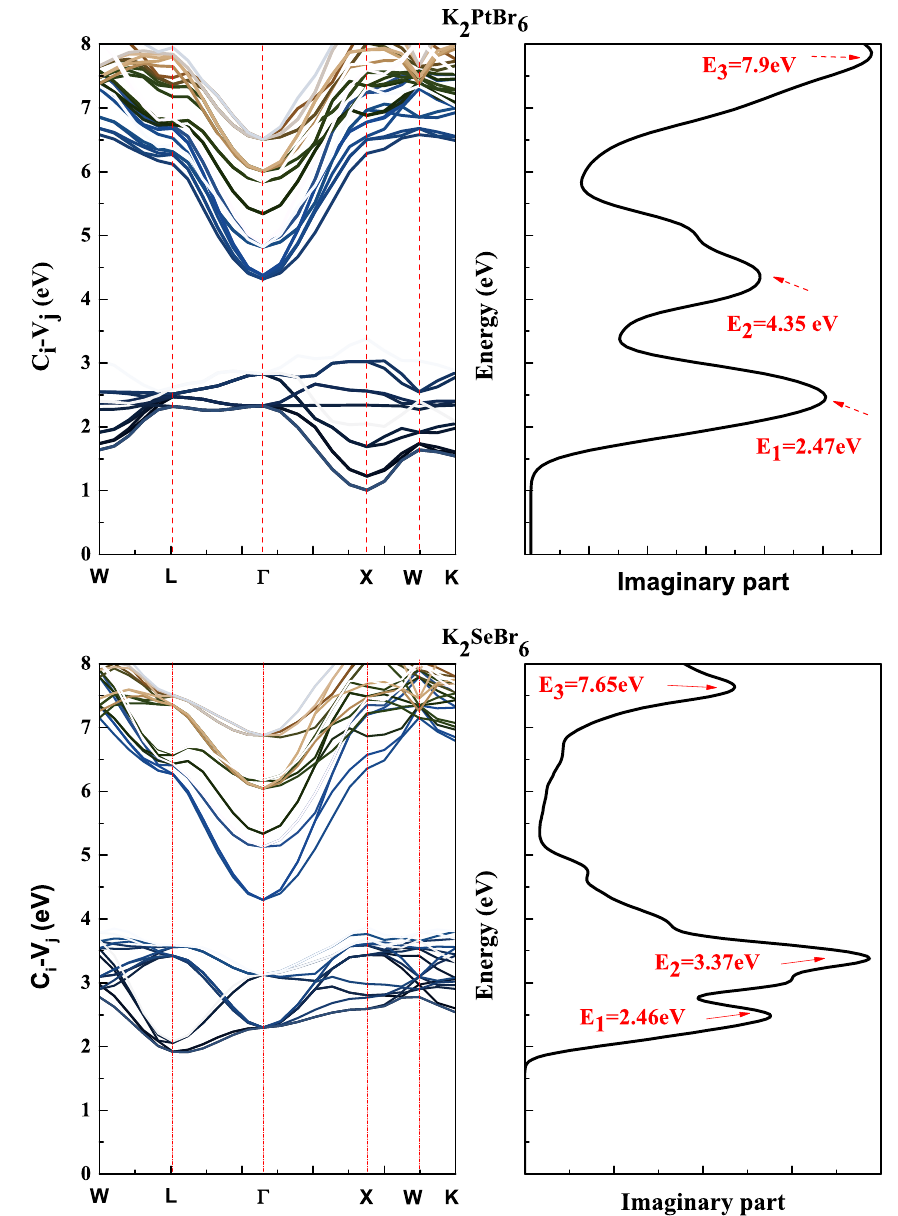
Figure 12. The imaginary part and transition energy in K 2 SeBr 6 and K 2 PtBr 6